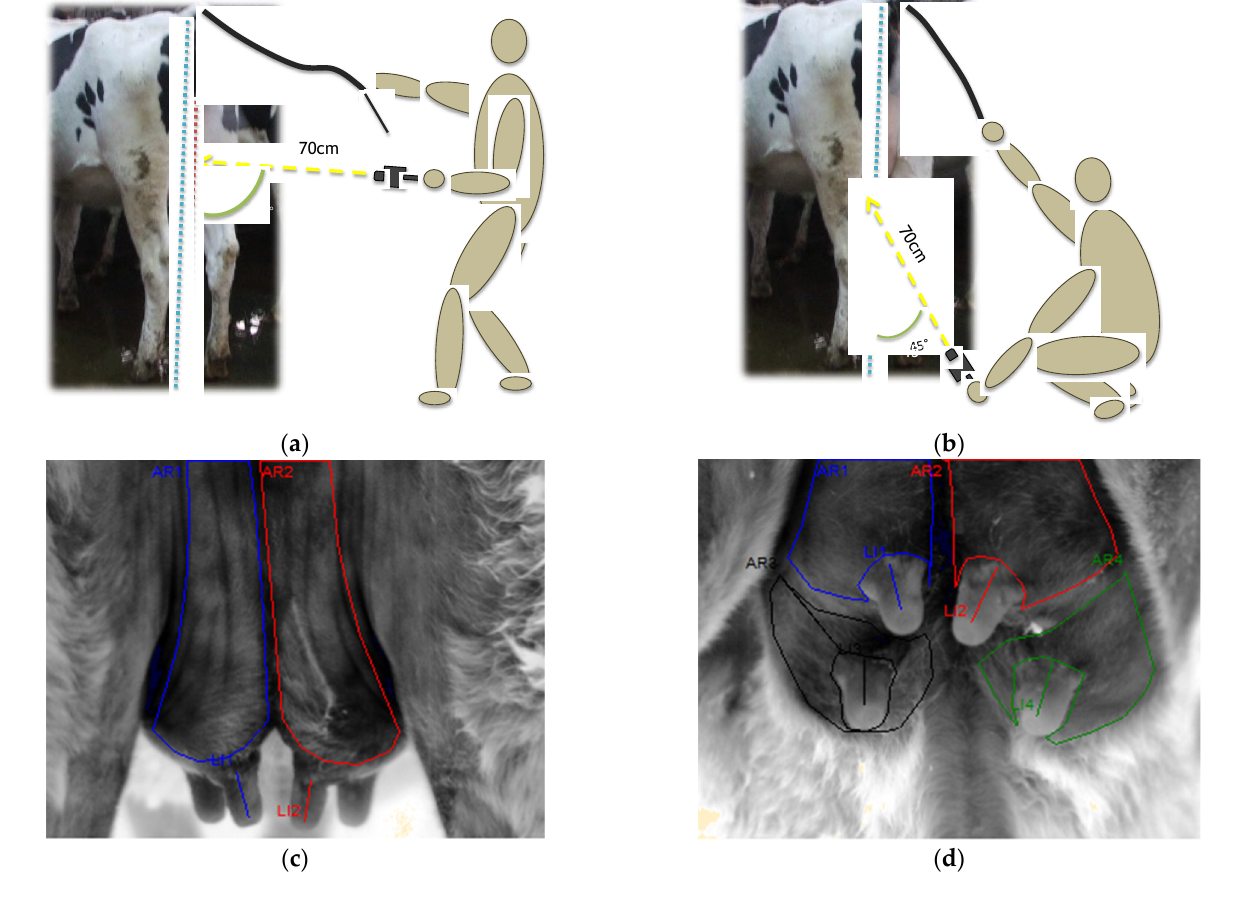
Figure 1. IRT projections and IRT image analysis (grey palette): ( a , c ) Cd-Cr—caudocranial projection; ( b , d ) Vt-Dr—ventrodorsal projection. AR—area defined by polygons tool; LI—line defined by lines tool. Colour area (quarter) and line (teat): blue—back left; black—front left; red—back right; green—front right.